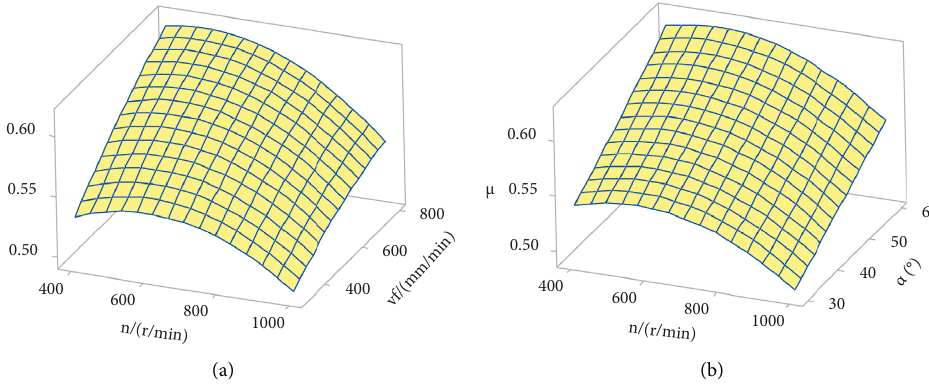
Figure 19: RS for n interacting with vf and α , respectively. (a) μ � f ( n , vf). (b) μ � f ( n , α ).